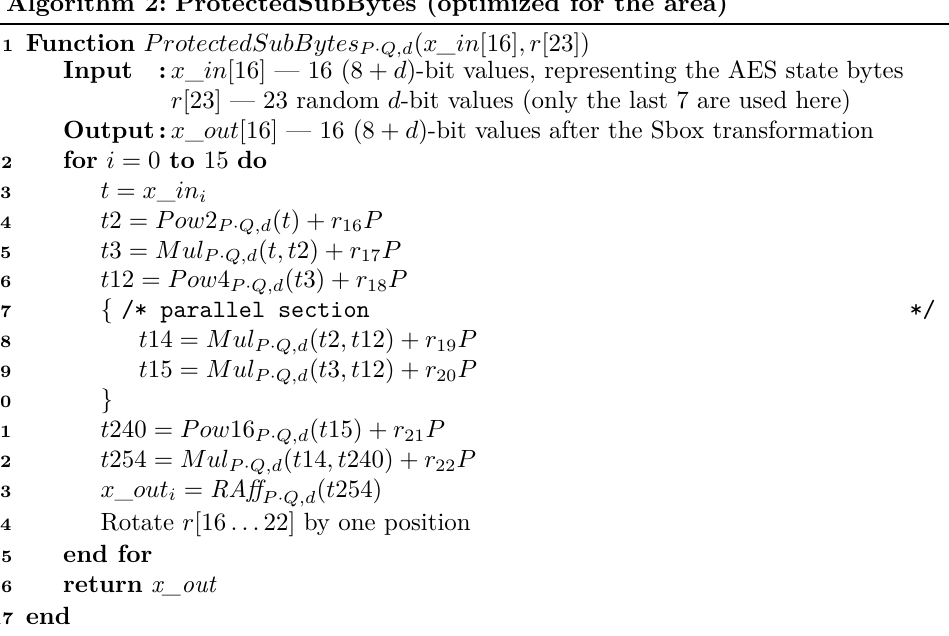
Algorithm 2 implements ProtectedSubBytes P · Q,d optimized for the minimal area. Algorithm 5 in Appendix B is an alternative version of the same function, optimized for the maximal frequency; in this version, the size of the array r must be 24 rather than 23. In both versions, the operations that can be performed in parallel are shown as an indented block in curled brackets. Algorithm 2: ProtectedSubBytes (optimized for the